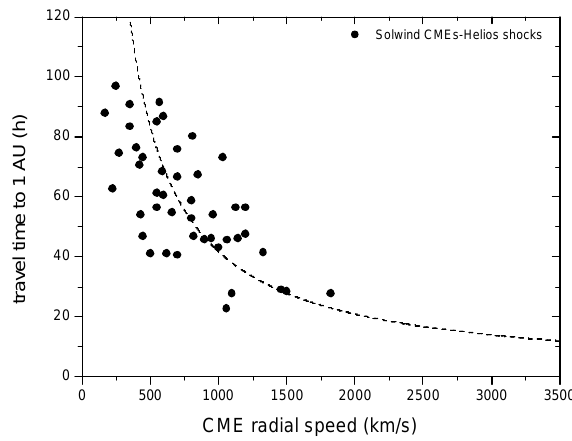
Fig. 4. The travel time of limb CME fronts from the Sun to the location of Helios 1 (at about 90 0 off the Earth-Sun line) as function of the CME radial speed V rad obtained from the SOLWIND coronagraph. Only those cases were selected where a unique association could be achieved, in particular when Helios 1 was with +/- 30 0 near the plane of the sky, and when the angular span of the CME included the Helios orbital plane. The travel time was derived from the moment of first appearance in a coronagraph image and the shock arrival time at Helios 1. The projected travel times to 1 AU as given in the figure were determined by simply assuming that the shocks would travel from the Sun through Helios and all the way to 1 AU at the same average speed . All data were adopted from Table 1 of Sheeley et al. (1985). The dotted line denotes the “ideal” line, i.e., where the travel time would exactly correspond to the CME radial speed near the Sun.